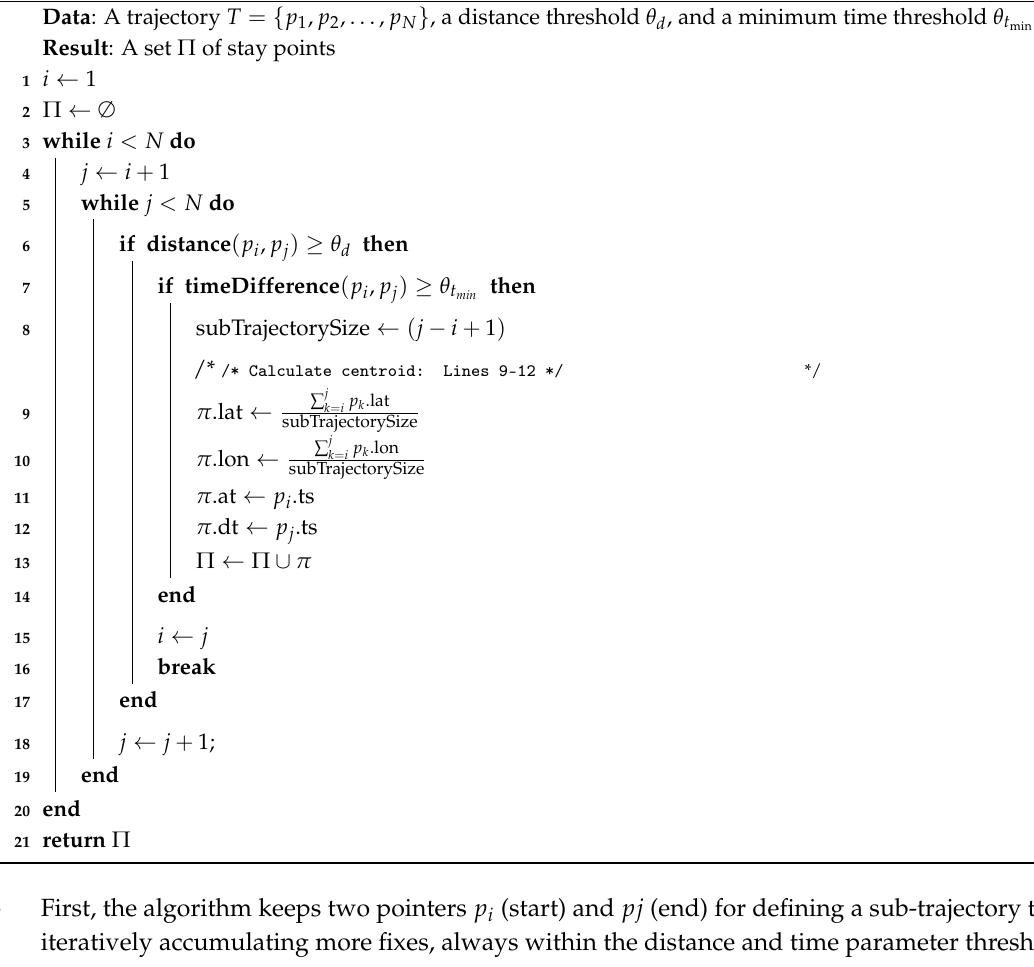
Algorithm 1: Algorithm for off-line stay points detection, proposed by Li et al.